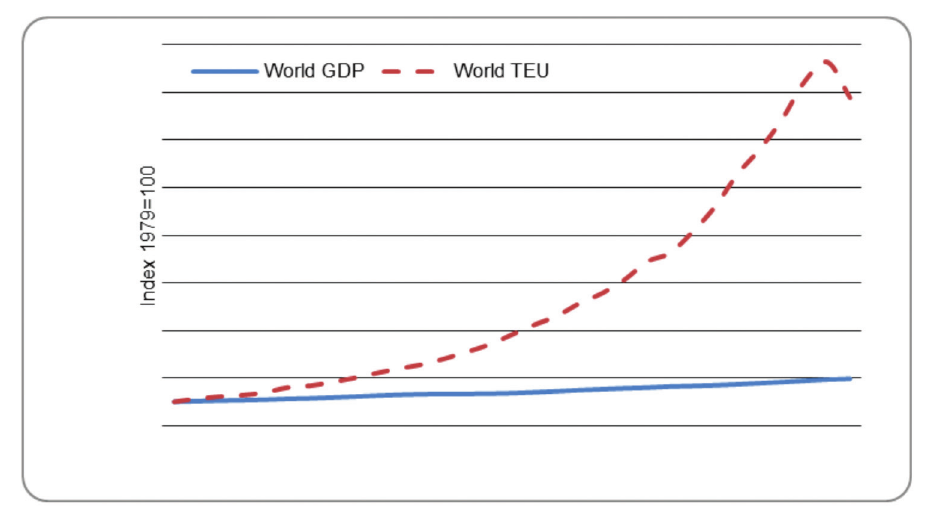
Figure 2: Growth in global container flows outstripping GDP growth over the last three decades (GDP data from IndexMundi, 2011; TEU data from Sooredoo, 2011)